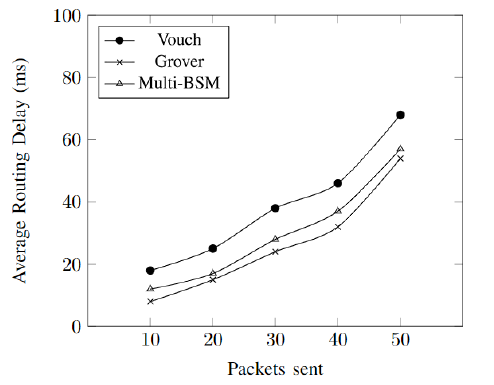
Figure 7. The comparison of average routing delays of the